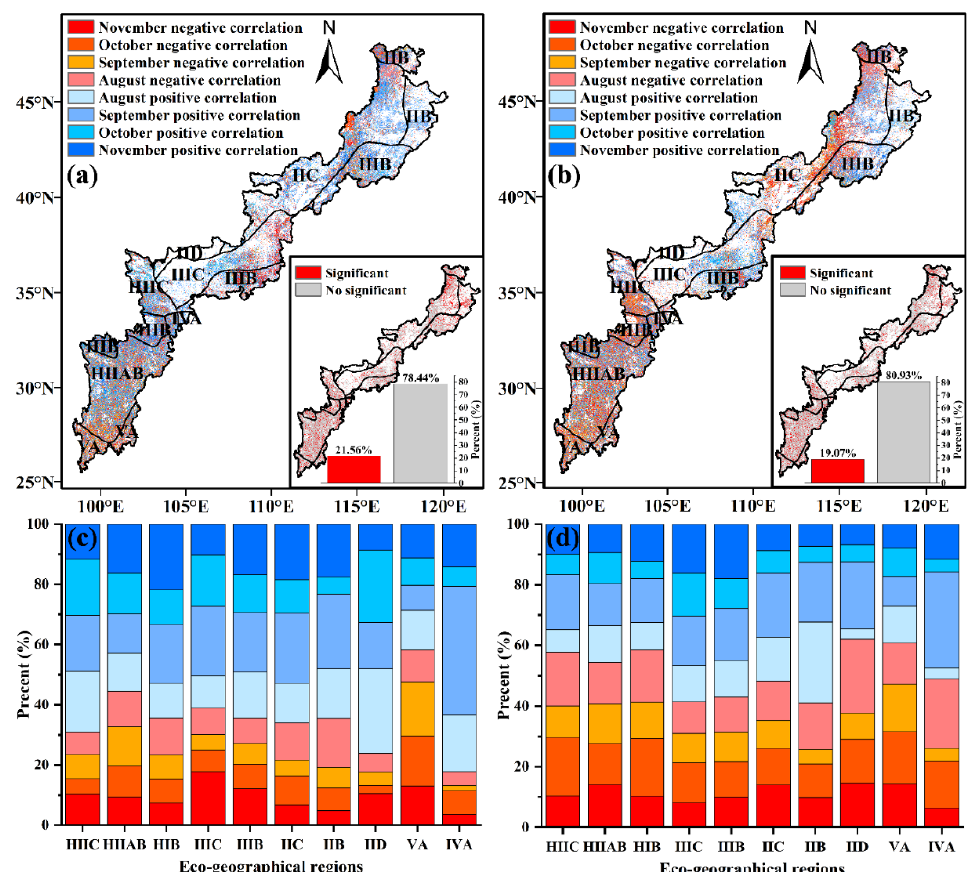
Figure 10. Spatial distribution of the correlations of the EOS with precipitation ( a ) and temperature ( b ) for the month with the greatest influence on them; The inset at the bottom right of each figure shows the pixels with a significance. ( c , d ) indicate the proportion of correlations between the EOS and the precipitation ( c ) and temperature ( d ) of the month with the greatest influence on it for different eco ‐ geographic regions, respectively.